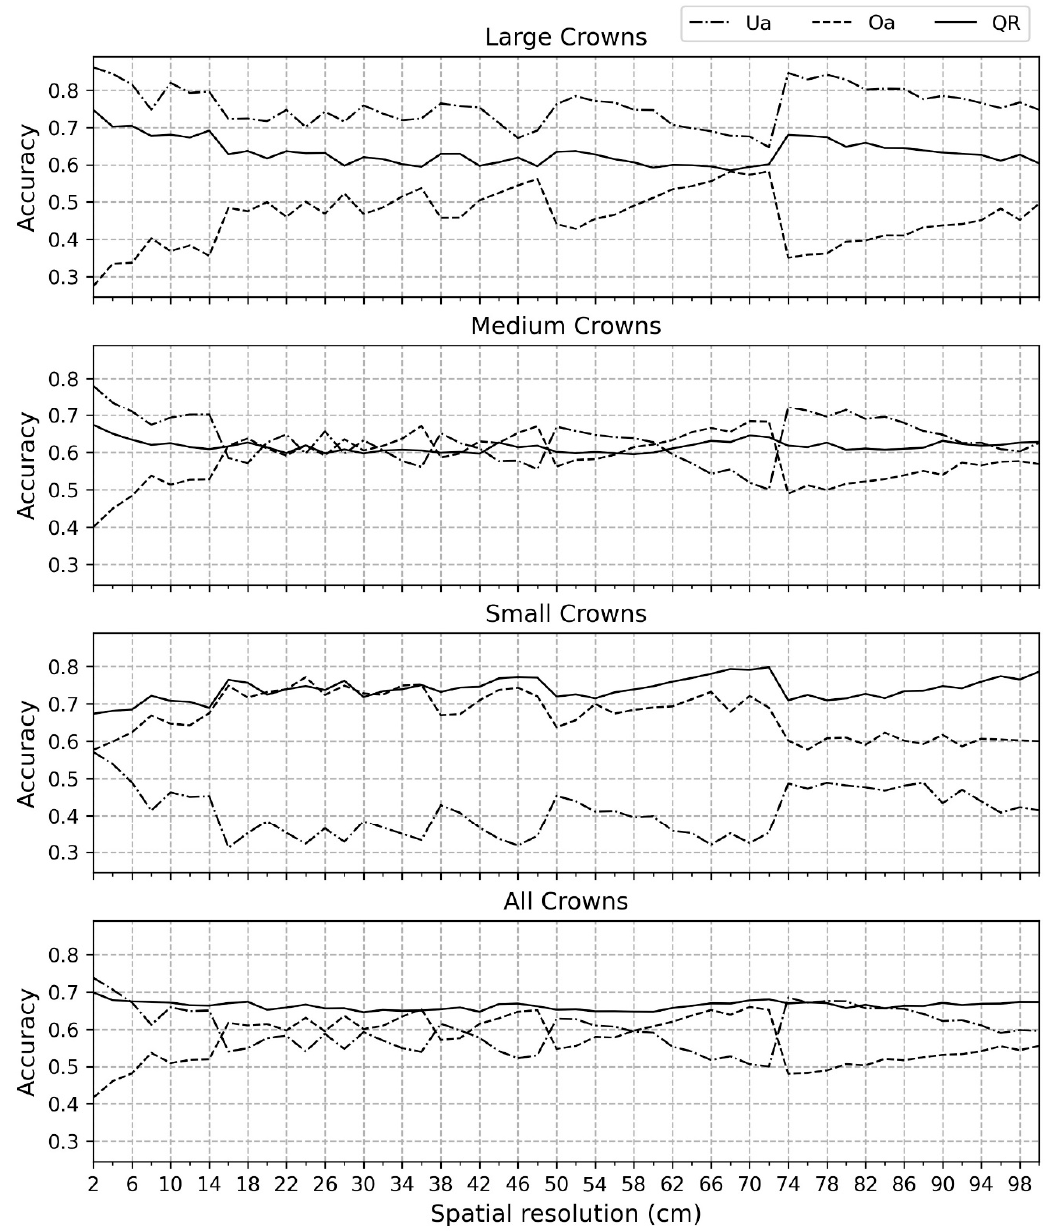
Figure 4. Impact of spatial resolution and crown size on Oa, Ua, and QR using the lightness band in study site #2.